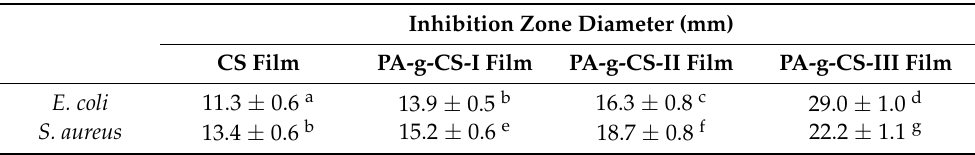
Table 1. Antibacterial activity of the CS and PA-g-CS films. Different letters indicate a significant difference ( p < 0.05).